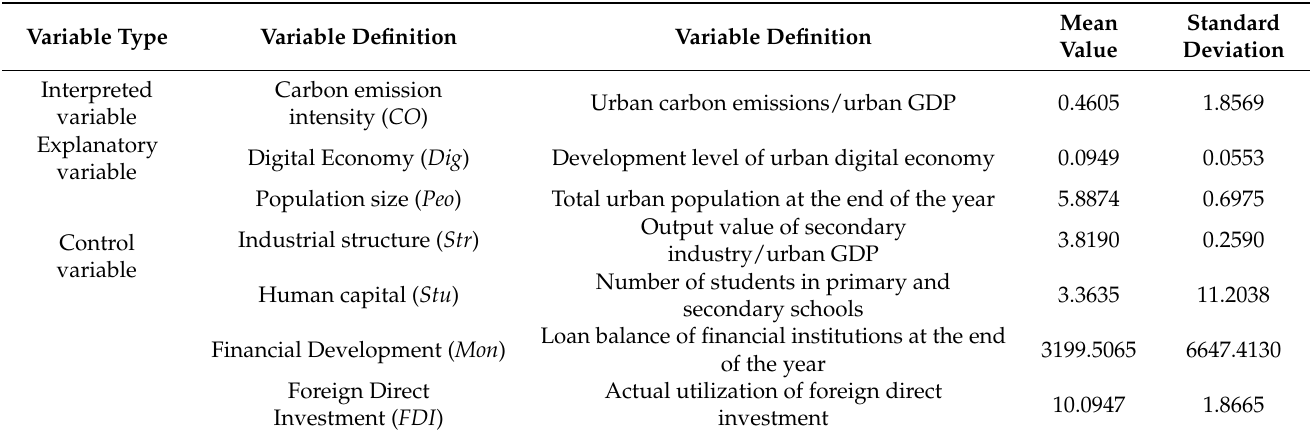
Table 1. Variable definition and descriptive statistical